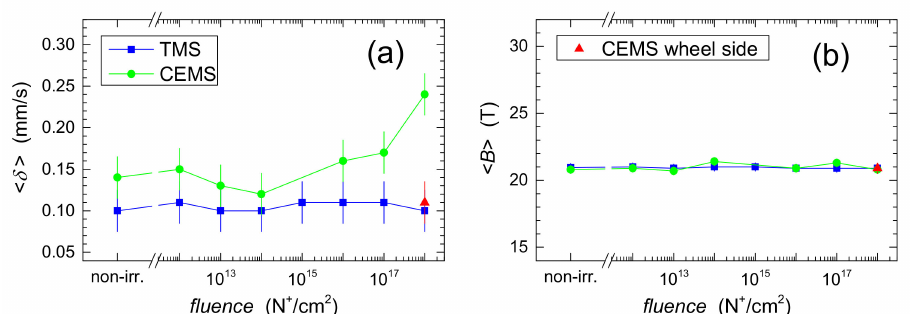
Figure 7. Parameters derived from transmission (TMS, blue) and CEMS (green) Mössbauer spectra of Fe 74 Cu 1 Nb 3 Si 16 B 6 irradiated by 110 keV N + ions plotted against the ion fluence: ( a ) average isomer shift, (cid:104) δ (cid:105) ; ( b ) average hyperfine magnetic field, (cid:104) B (cid:105) . Red triangles correspond to CEMS spectrum taken from the wheel side of the ribbons. Solid lines are only guides for the